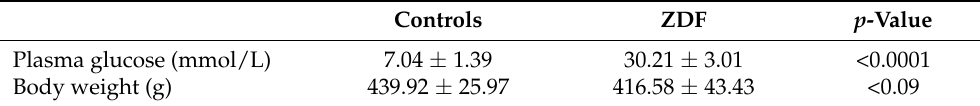
Table 1. Non-fasting plasma glucose levels and the body weight of the control and Zucker diabetic fatty (ZDF) rats with type 2 diabetes mellitus ( n = 16 per group). Data are expressed in mean ± SD; p -value—ZDF vs.